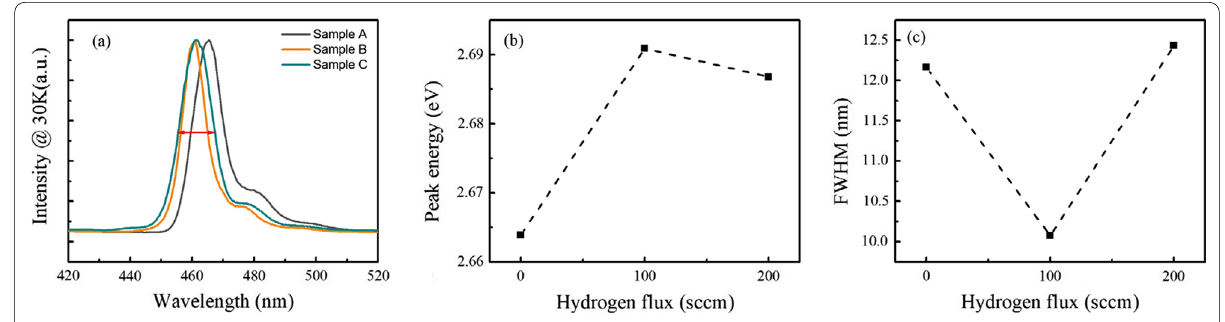
Fig. 4 The PL spectra at 30 K ( a ); the peak energy ( b ) and FWHM ( c ) of sample A, B and C through gauss fit of the PL